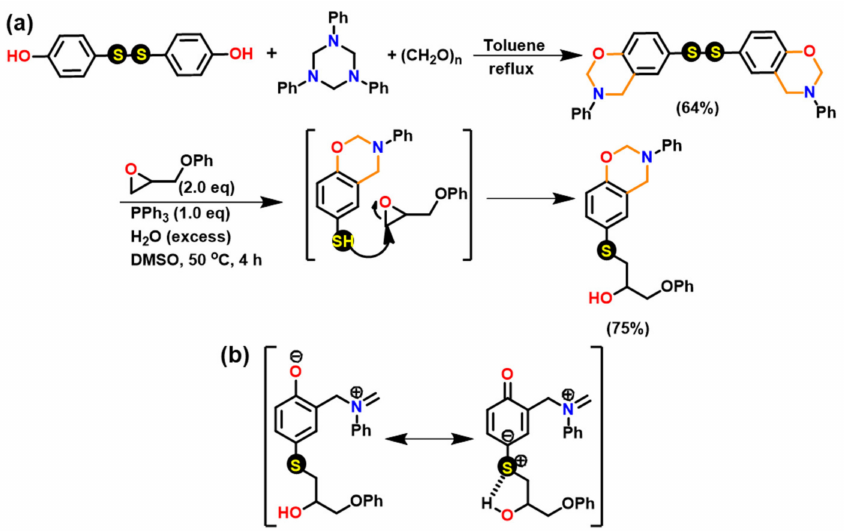
Figure 41. ( a ) Syntheses of sulfide-functionalized benzoxazines by the reaction of the in situ generated thiol Bz with epoxide. ( b ) Plausible acceleration mechanism for polymerization due to stability of the ring-open intermediate